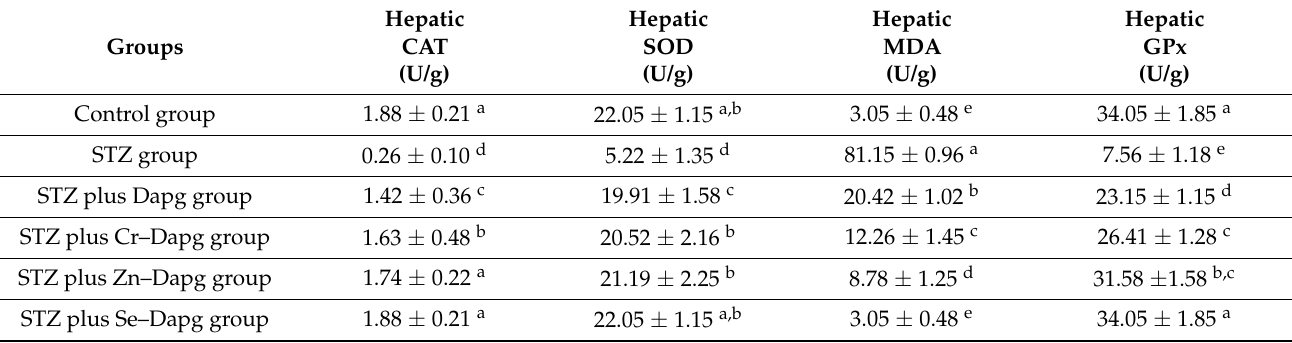
Table 3. Oxidative/antioxidant parameters of antioxidant enzymes in hepatic tissue of male